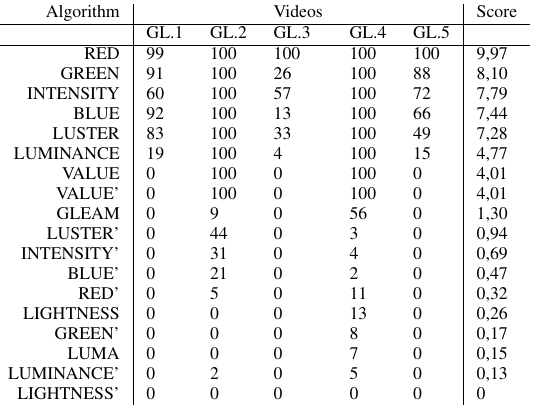
TABLE IX T EMPLATE 3: % OF TRACKED FRAMES AND THE SCORE PROPOSED Algorithm